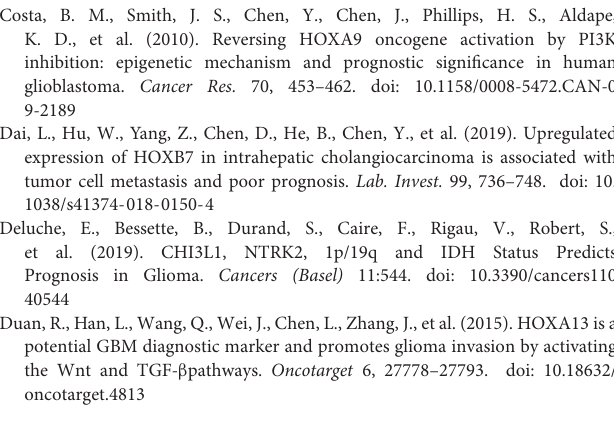
Supplementary Figure 1 | The survival trends of HOXB7 high expression group in lower grade gliomas. (A,B) CGGA RNA-seq database; (C,D) Ditan database. Supplementary Figure 2 | The expression of HOXB7 protein is weakly positive in the hot field of two cases of oligodendrogliomas. The medium positive tumor cells are located in the lower right corner of case 1. The semi-quantitative scoring of HOXB7 protein expression is 2. The small number of weakly positive tumor cells scattered in case 2. The semi-quantitative scoring is 1 (HE, EnVision, serial sections, Original magnification ×